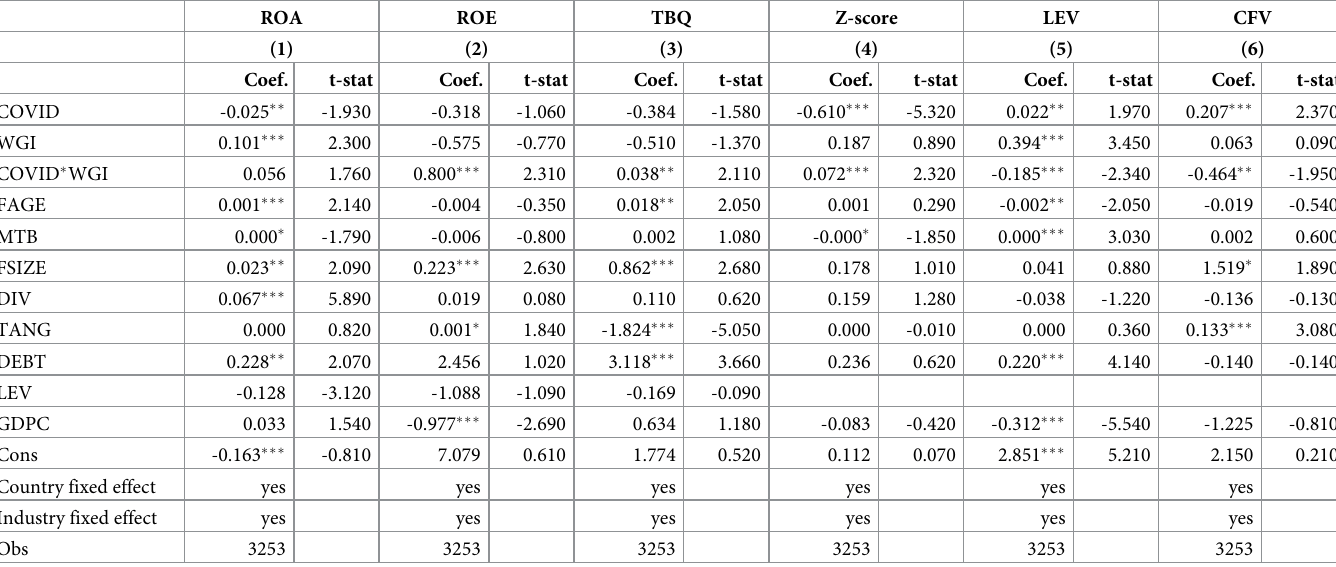
Table 6. Country governance quality and the impact of COVID-19 on firm risk and firm